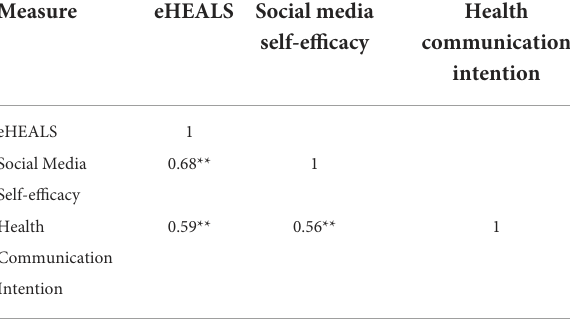
TABLE 3 Bivariate correlations among measures ( N = 958). Measure eHEALS Social